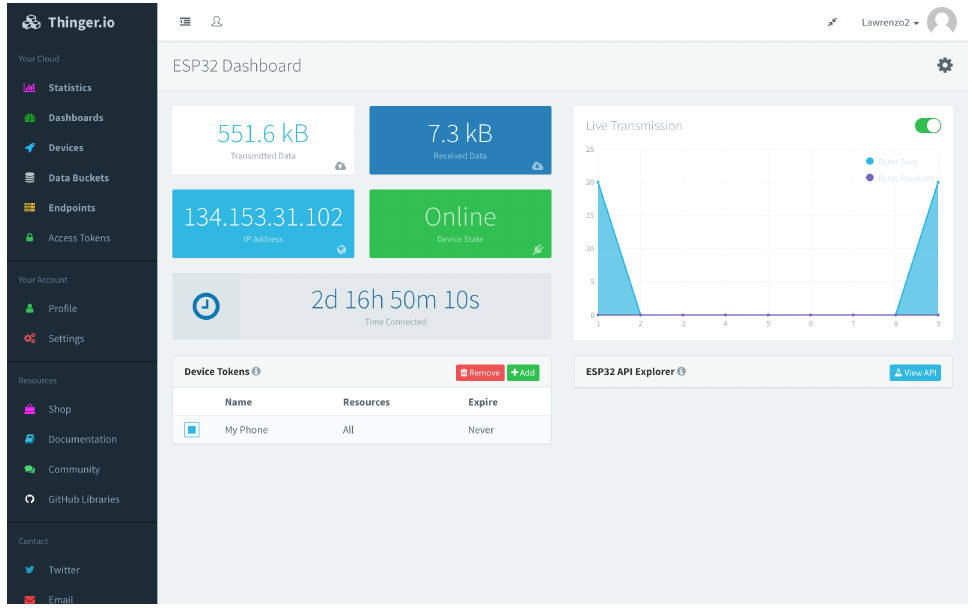
Figure 6. Thinger.IO Cloud